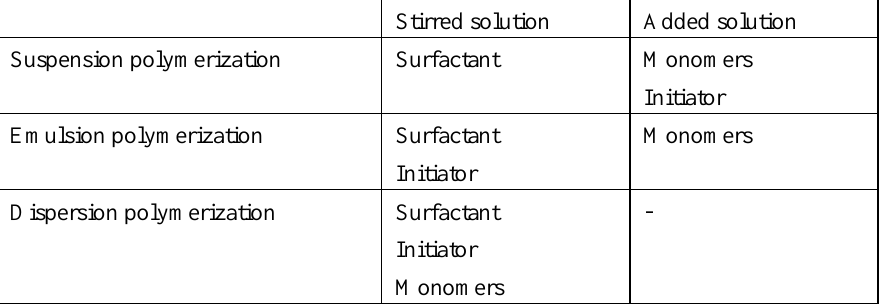
Table 1. Composition of the stabilizing phase and the monomer-solution for suspension polymerization. The monomers are mixed with the stirred, stabilizing solution for the synthesis of polymeric